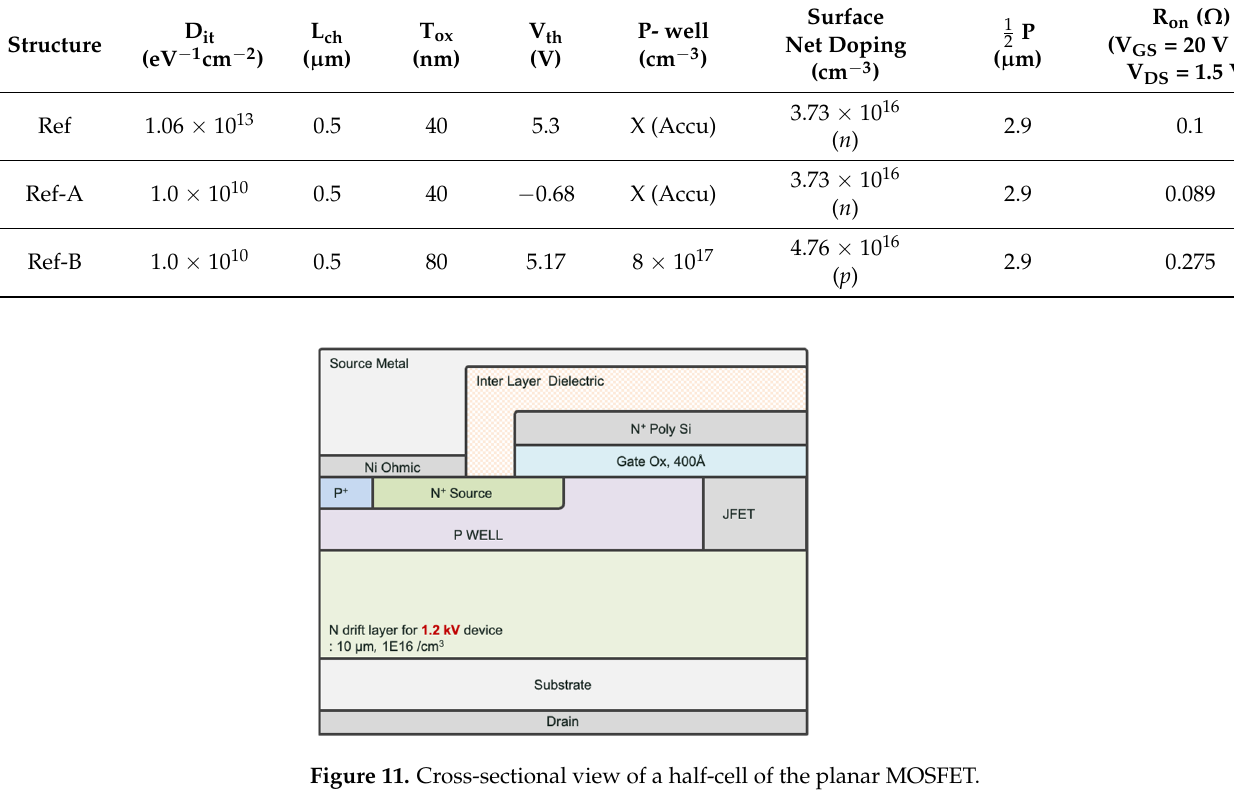
Table 2. Summary of the work tabulated with various scenarios. Each case represents a variation in design parameters with a reference design. The resultant threshold voltage and on-resistance are also tabulated.